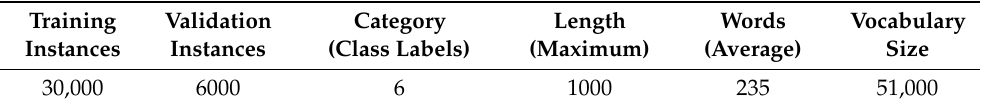
Table 2. Dataset summary.